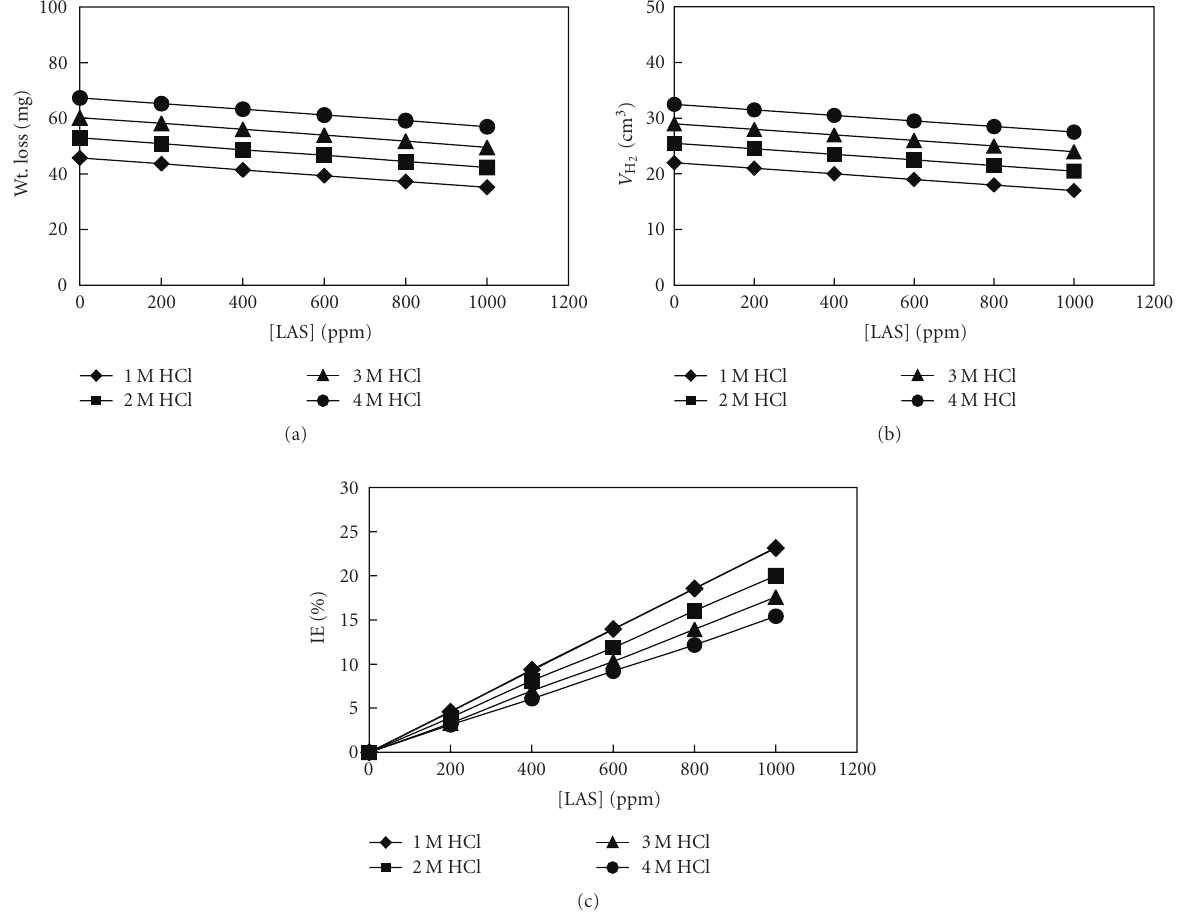
Figure 1: Change of (a) weight loss, (b) volume of H 2 gas, and (c) Inhibition e ffi ciency (%IE) with LAS concentration using di ff erent HCl concentrations in absence of magnetic field for 1.0 hour exposure at 20 ◦